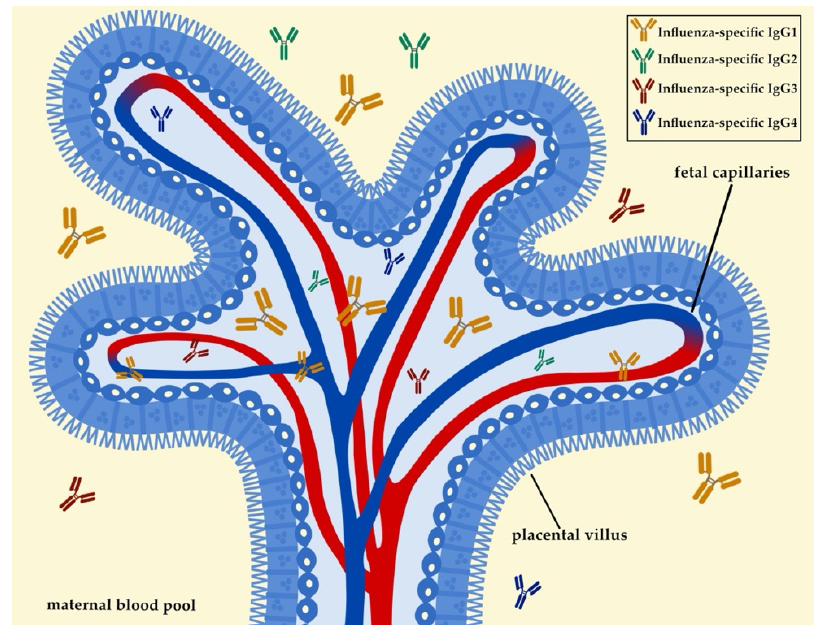
Figure 1. One of the main mechanisms of vertically transferred immunity during pregnancy is the transplacental transfer of IgG. IgG1 is the main subtype that is predominantly transferred to the infant, with other subtypes being transferred to a lesser degree. The transport of IgG across the placental barrier is mediated by the FcRn. FcRn is primarily expressed in placental syncytiotrophoblasts, the outermost layer of the placental villus. This figure was created with Bio Render, Inkscape, and Affinity